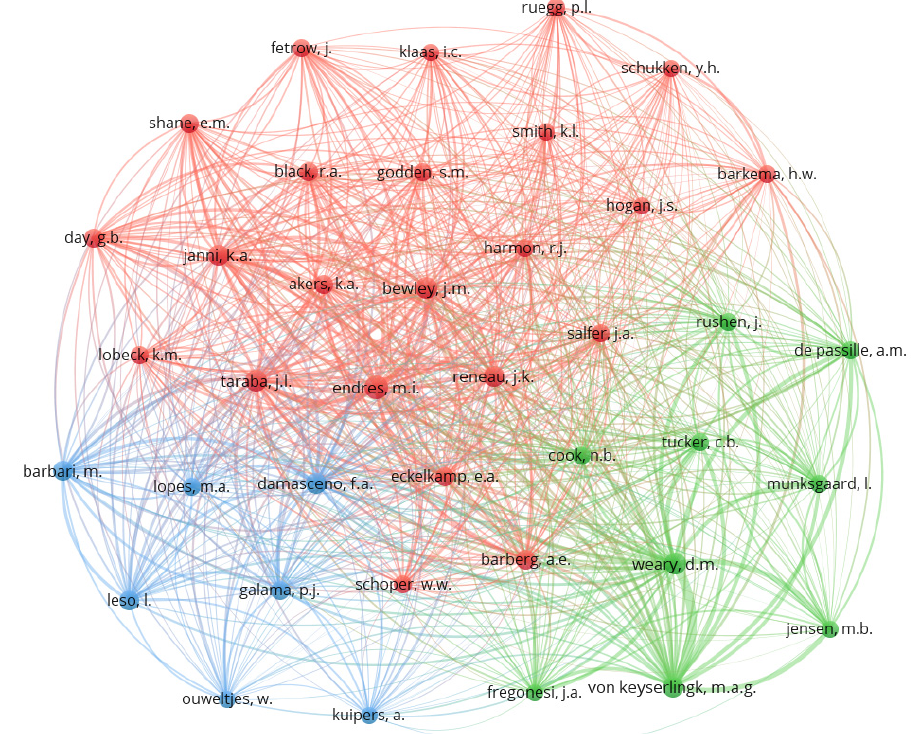
Figure 3. Scientific mapping of the co-citation of the most relevant authors in compost barn research.